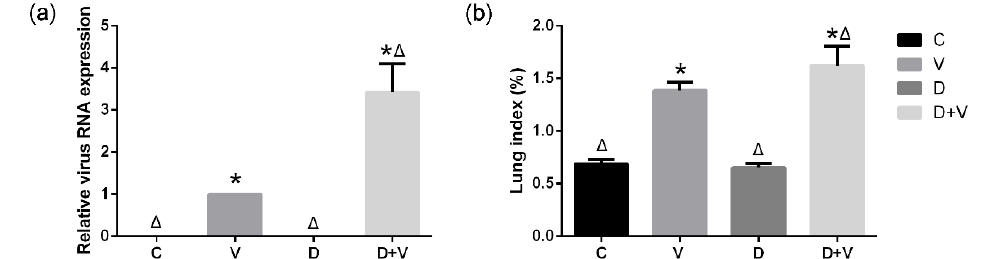
Figure 6. Relative expression of viral RNA in the lung and the lung index. ( a ) Relative expression of viral RNA in the lung. Each sample was run in triplicate and averaged to ensure accuracy. The 2 − ∆∆ CT method was used for analysis of the relative virus amplification. The values of groups C, D, and D + V represent the fold change relative to group V which was converted to 1. ( b ) Lung index. The formula used was as follows: lung index = (lung weight/body weight) × 100%. * p < 0.05 compared with group C; ∆ p < 0.05 compared with group V. Group designations were as follows: control (C); virus infection